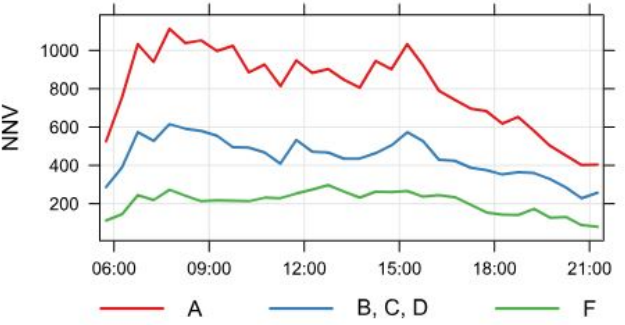
Figure 2. Normalized number of vehicles (NNV) on an average day at measuring points. At measuring point B, numbers are slightly lower. The NNV for this measuring spot is shown in Figure 2 and is marked with a blue line. The blue line shows the average number of NNV for measuring points C and D, as the traffic flow is the same for all three measurement areas. Here 12,920 diesel vehicles represent the mean traffic flow in a working day; 10,011 of those are private motorized vehicles, the number of buses is 204, and freight vehicles are numbered at 2705. Daily rush hour was also taken into consideration at point